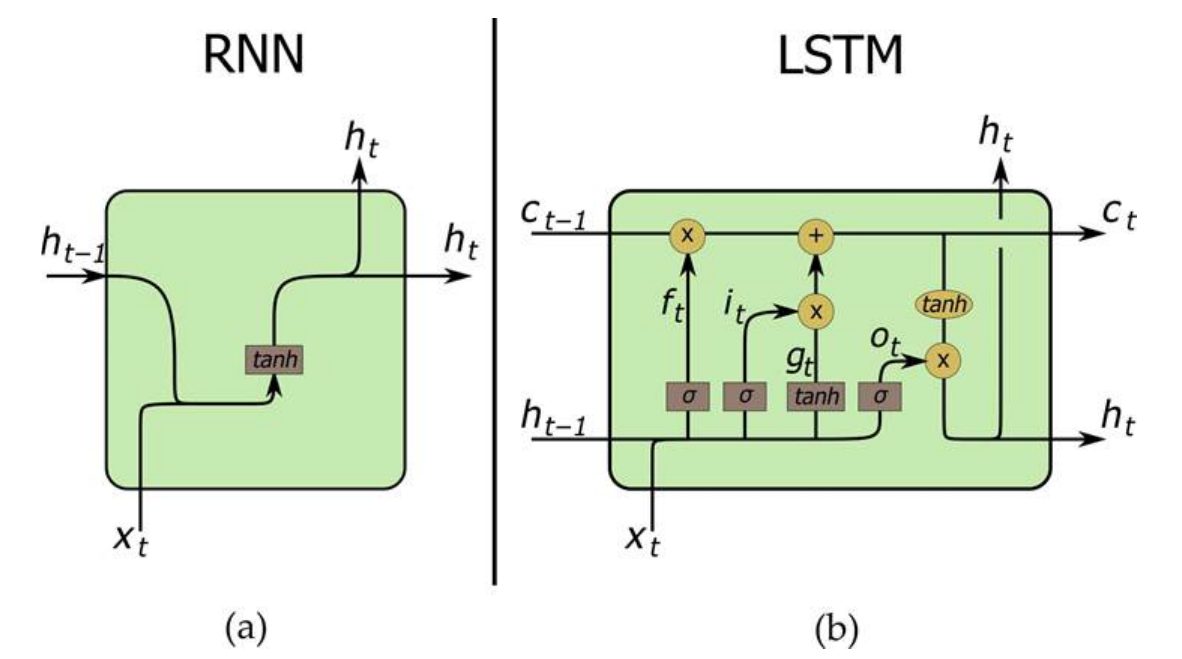
Figure 2. ( a ) The architecture of a RNN cell is displayed on the left side with x being the input and h the internal state; t indicates the current timestep. ( b ) Internals of the LSTM cell with h referring to the hidden state, c the cell state, f the forget gate, i the input gate and o the output gate at timestep t . Further details are explained by Equations